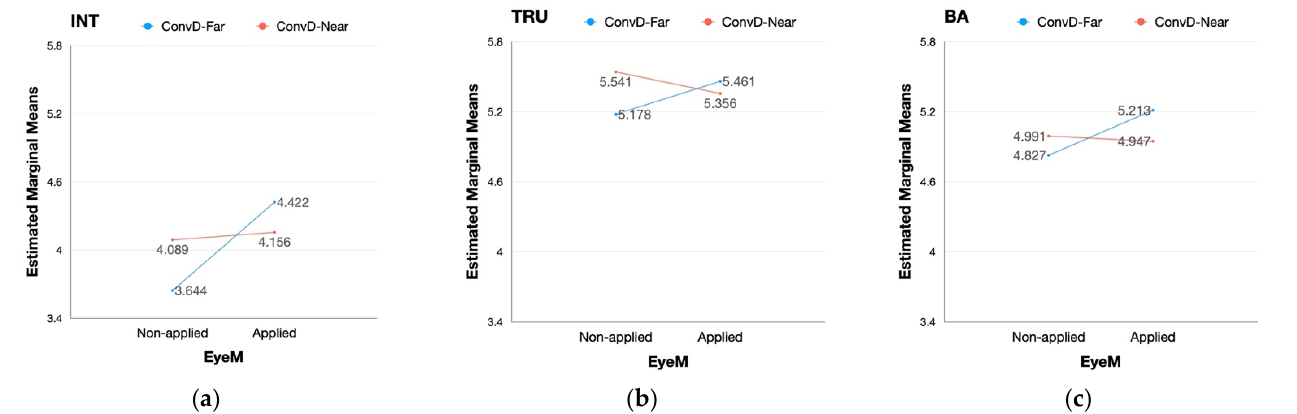
Figure 6. Public shuttle scenario: interaction effect between eye movement (EyeM) and conversational distance (ConvD); ( a ) interaction effect on intimacy; ( b ) interaction effect on trust; ( c ) interaction effect on brand attitude.